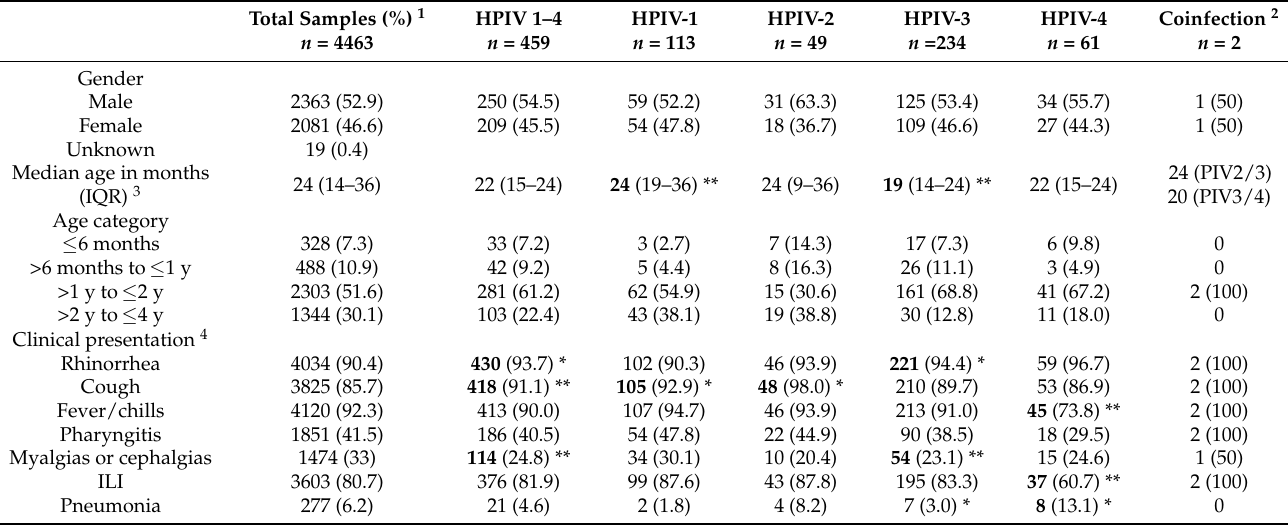
Table 4. Demographic and clinical data by